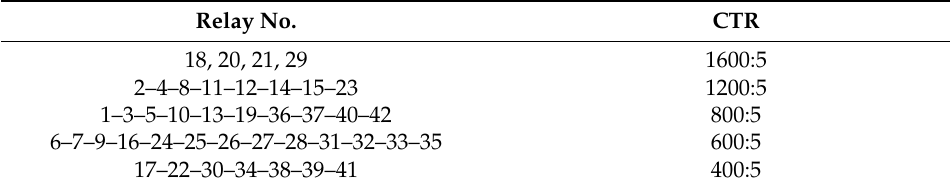
Figure 8. Convergence characteristics of HHO for the 9-bus system. Table 4. Current transformer ratio. Table 4. Current transformer ratio. Relay No. Relay